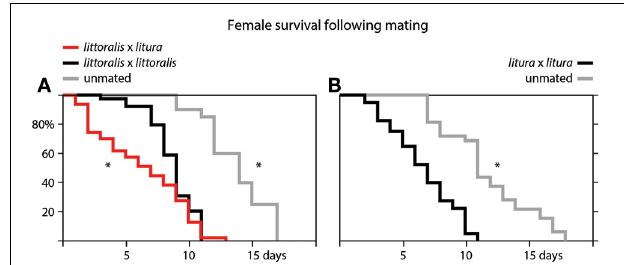
FIGURE 3 | Survival curves of (A) virgin (gray), conspecific (black) and heterospecific (red) mated female Spodoptera littoralis , and (B) virgin (gray) and conspecific (black) mated female S. litura . Differences in the survival curves are significant at p < 0 . 05 (*Gehan-Wilcoxon